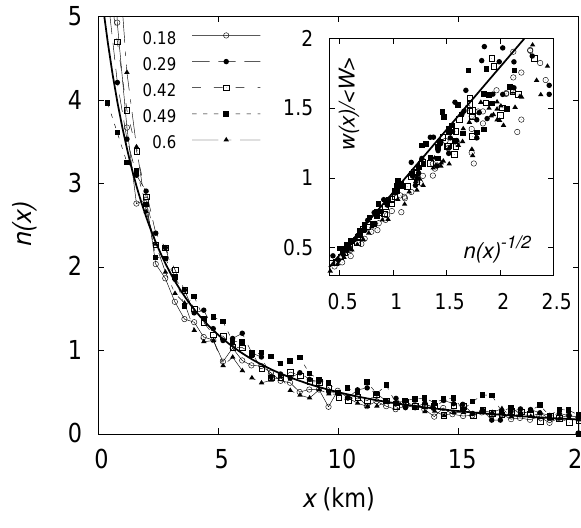
Fig. 13. Normalized local dune density n(x) ≡ N(x)(x max /dx)/N , where N(x) is the fraction of the total number of dunes N placed between x − dx and x + dx , as function of the downwind distance x for different input dune densities (symbols). The solid line corre- sponds to the 1 /w 2 (x) fit (see text). Inset: the local dune mean size √ n(x) (solid line). w(x) scales as h w i /